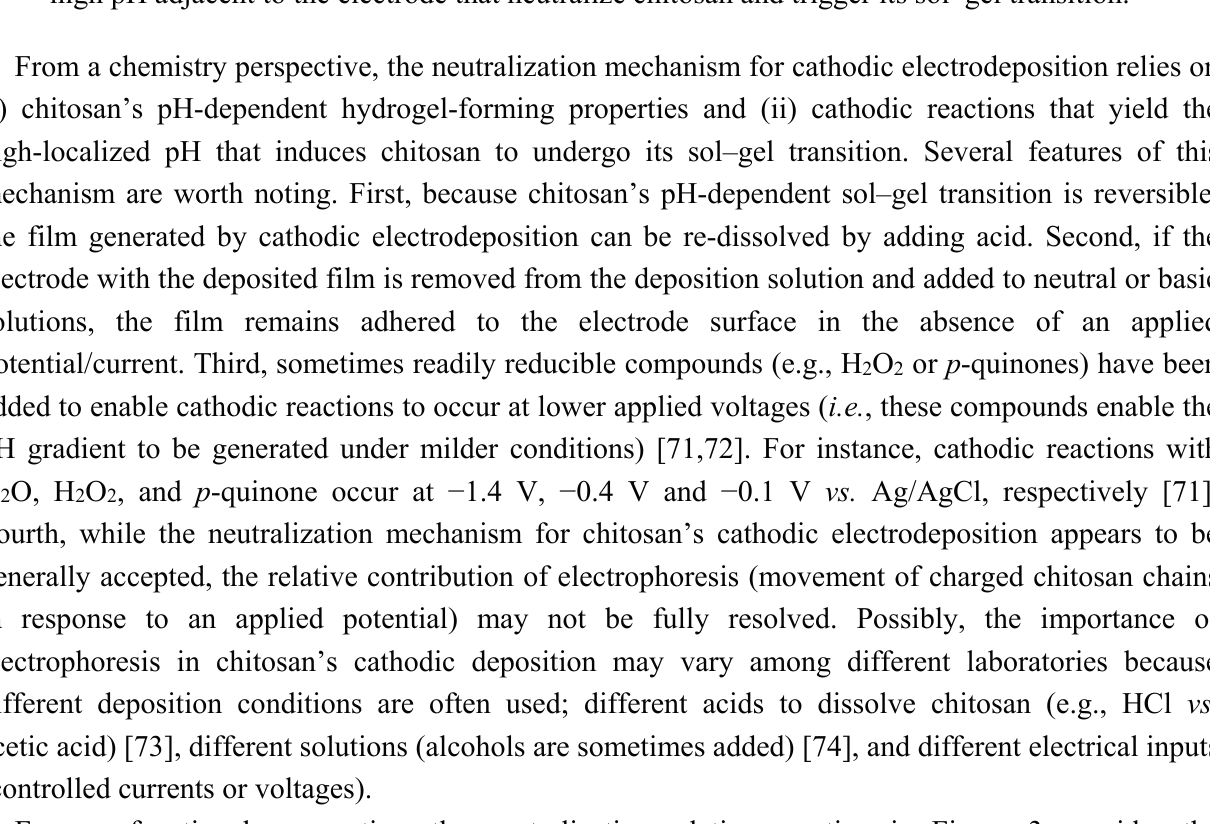
Figure 3. Chitosan’s cathodic electrodeposition. Cathodic reactions generate the localized high pH adjacent to the electrode that neutralize chitosan and trigger its sol–gel